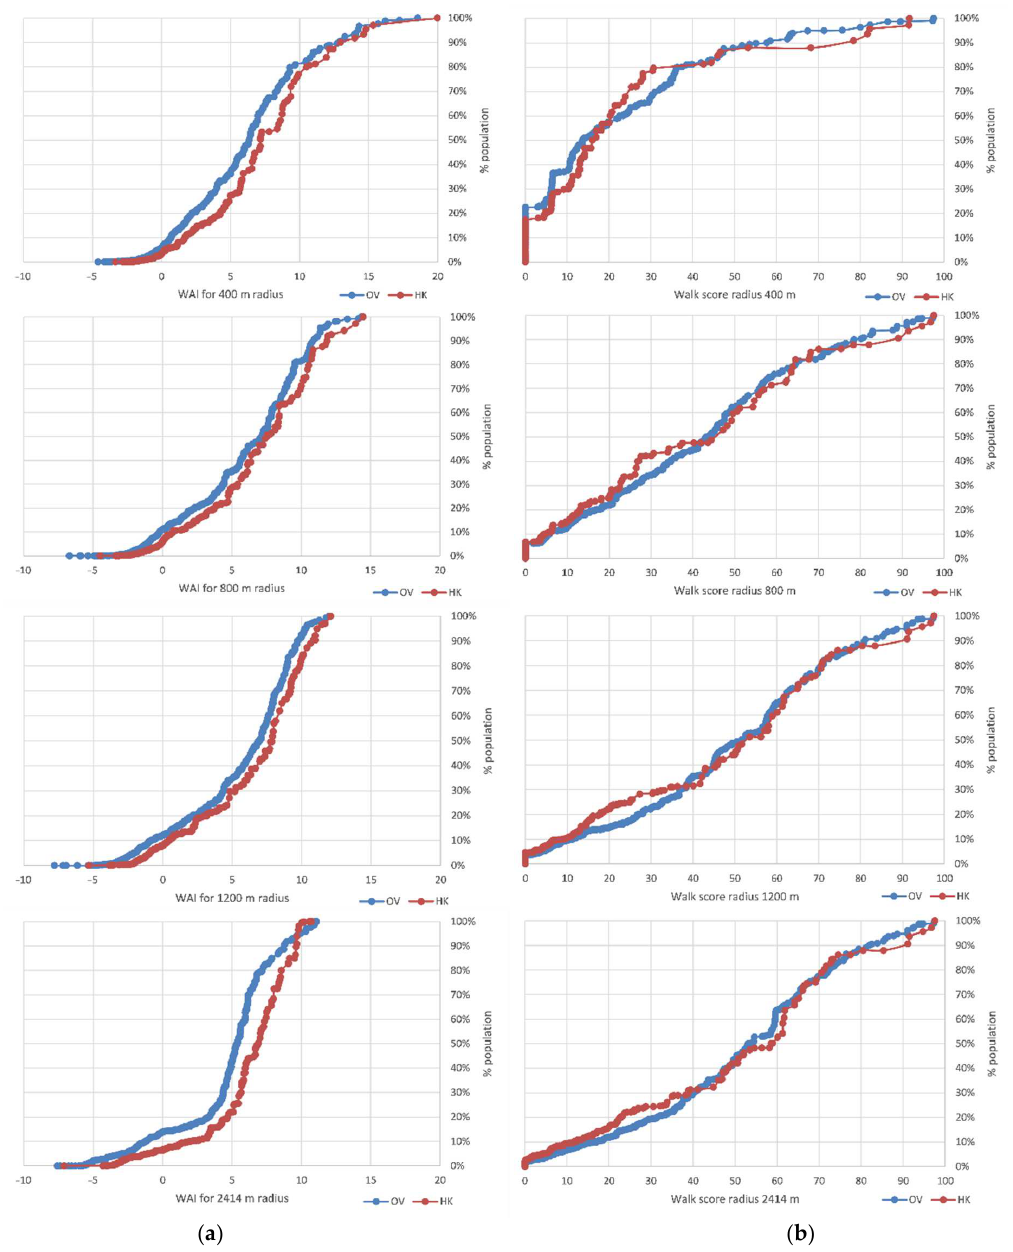
Figure 9. Distribution function of population for different buffer sizes according to WAI ( a ) and WS ( b ) walkability.